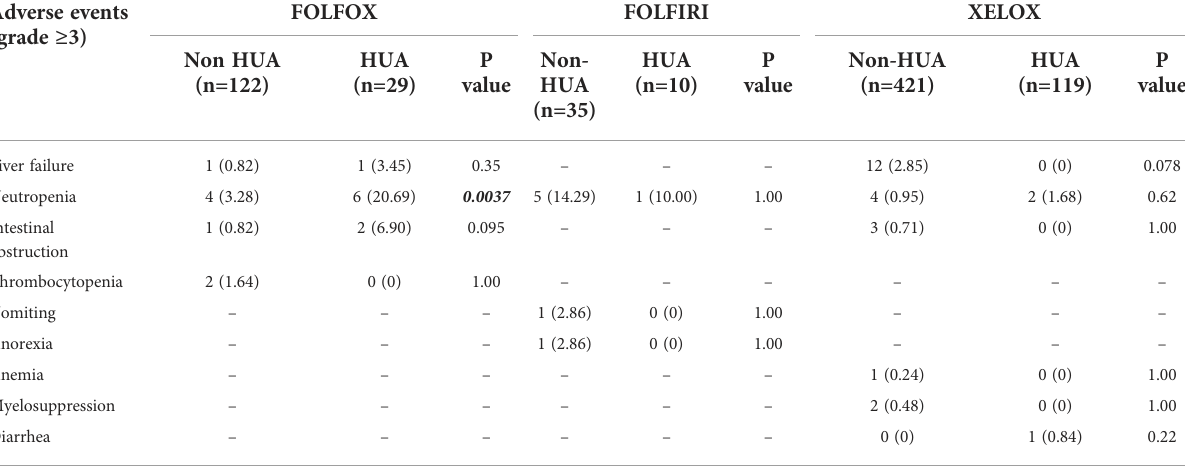
TABLE 5 Relationship between baseline SUA levels and safety in colorectal cancer patients treated with postoperative chemotherapy. Adverse events (grade ≥